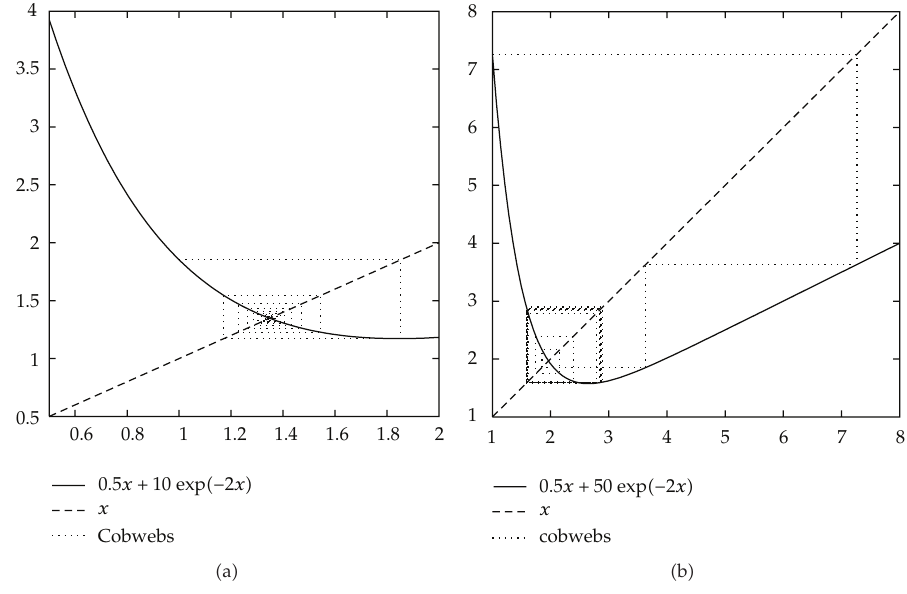
Figure 2: Some iterations for (cid:4) 2.1 (cid:5) with α (cid:8) 0 . 5 , p (cid:8) 10 , q (cid:8) 2 (cid:4) a (cid:5) and α (cid:8) 0 . 5 , p (cid:8) 50 , q (cid:8) 2 (cid:4) b (cid:5) . In the former case all positive solutions converge (cid:4) oscillatory (cid:5) to the positive equilibrium x ≈ 1 . 35, and in the latter case the solution converges to a stable two-cycle ≈ 2.86,